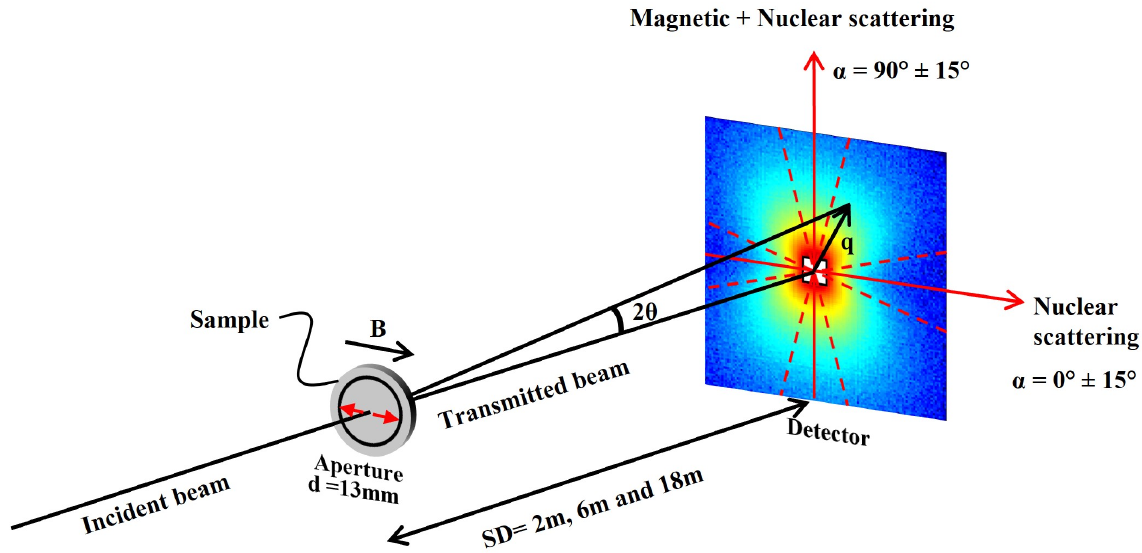
Figure 1. Schematic of the small-angle neutron scattering (SANS) setup used at SINQ, and the SANS-I Figure 1. Driving simulator—billboard. instrument, Paul Scherrer Institute